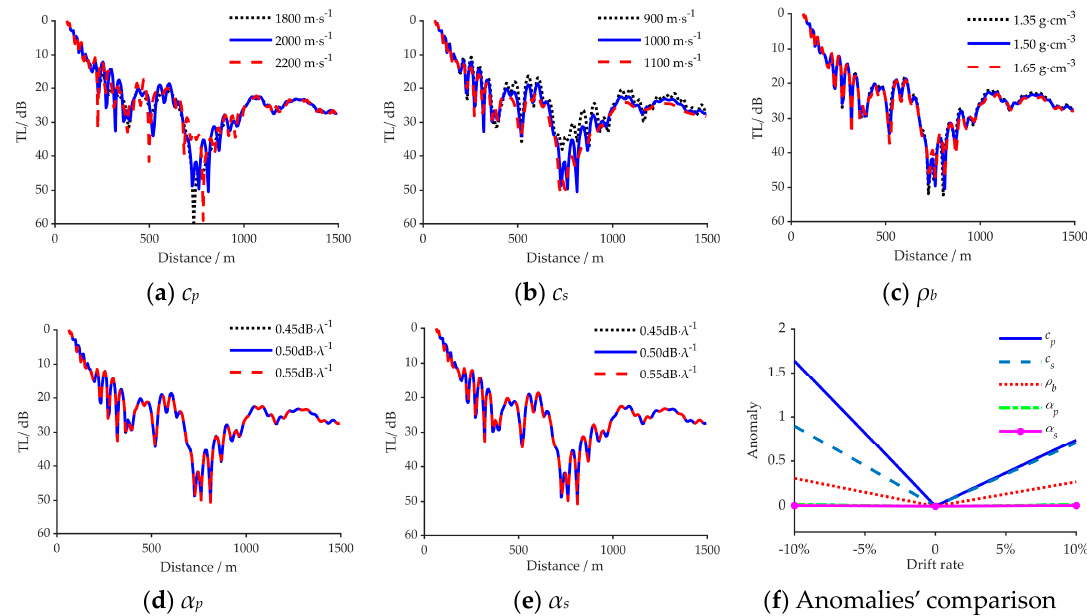
Figure 4. The influence of the five geoacoustic parameters on acoustic propagation, ( a )-( e ) corresponds to the c p, c s, ρ b, α p and α s respectively, ( f ) reveals the comparison of TLs’ anomalies when the value of each parameter was changed.